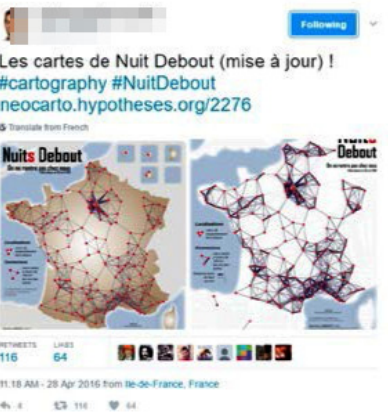
Figure 3. Tweet representing information flows during the Paris protests of #nuitdebout in 2016. Note: We obtained the user’s consent to reprint the tweet; user‐ name and faces of depicted people were pixelated to guarantee anonymity.